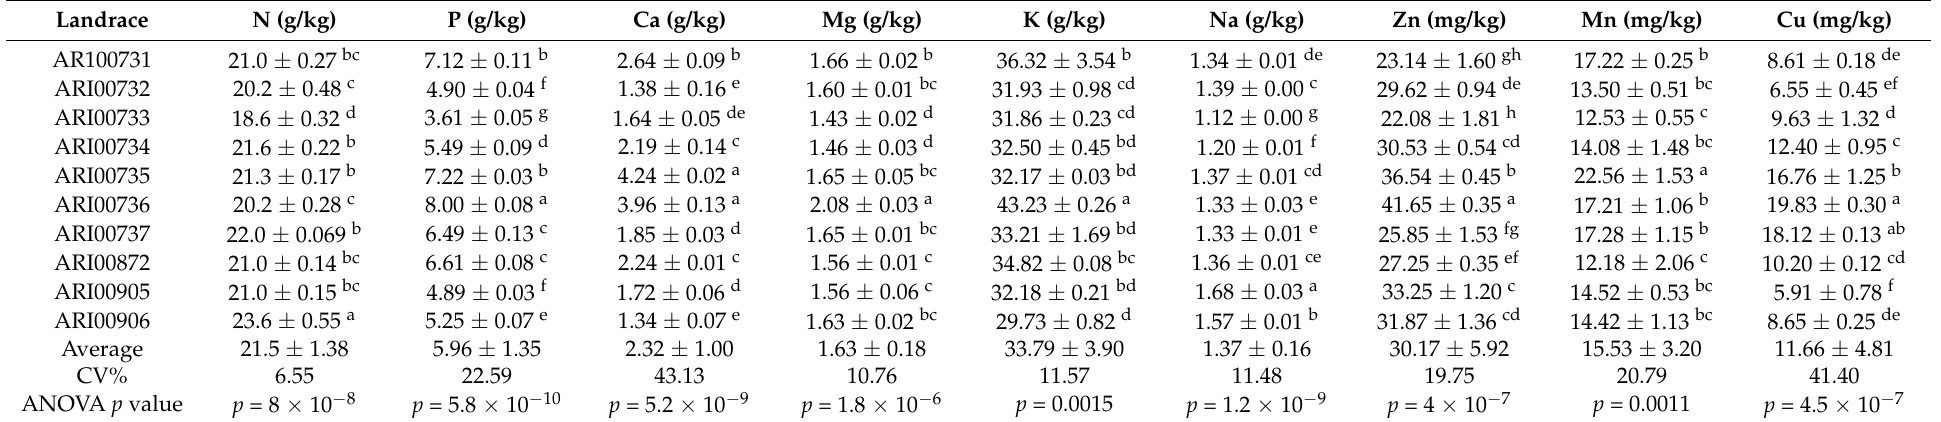
Table 4. Mineral composition across tomato